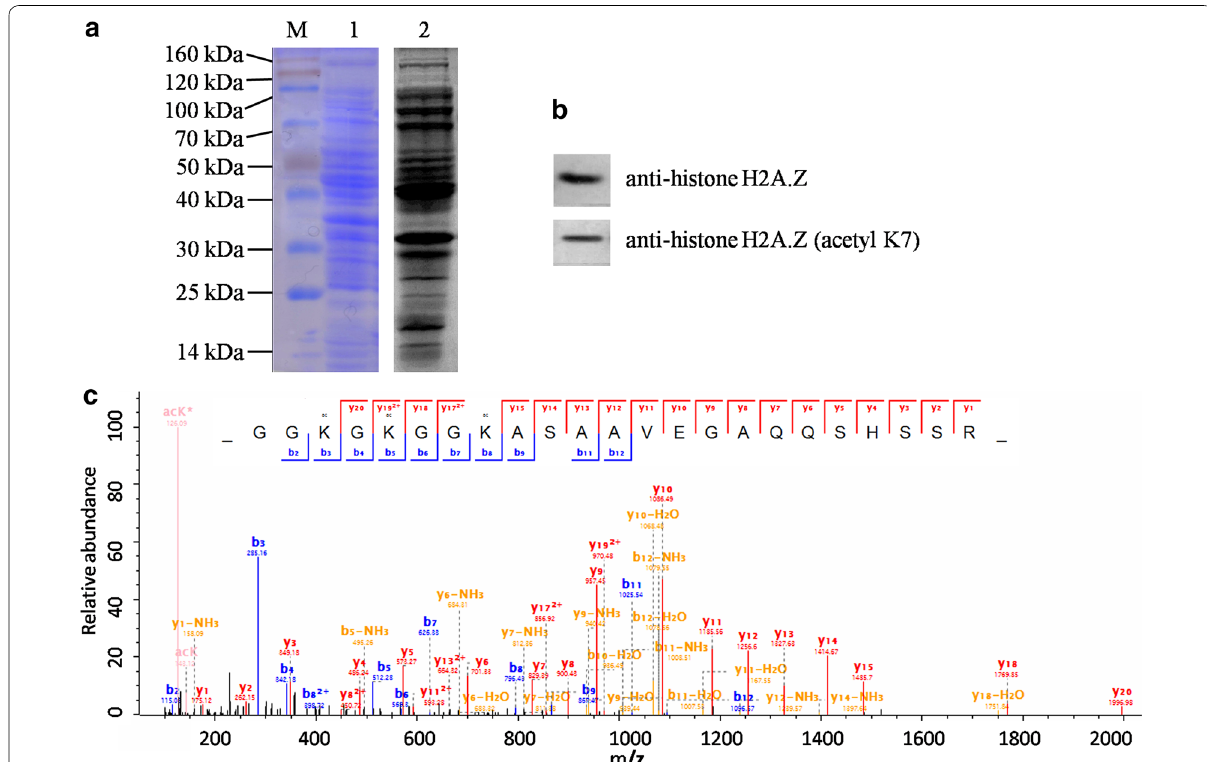
Fig. 3 An overview of lysine acetylation in Y. lipolytica as analyzed by SDS-PAGE and Western blotting. a 100 μg of total protein was separated by SDS-PAGE ( 1 ) and the acetylated proteins were detected with pan anti-acetyl lysine antibody ( 2 ). b The Western blotting signal with anti-histone H2A.Z antibody and anti-H2A.Z (acetyl K7) antibody. c MS/MS spectra of acetylpeptide with an acetylation site at K7 of histone H2A.Z